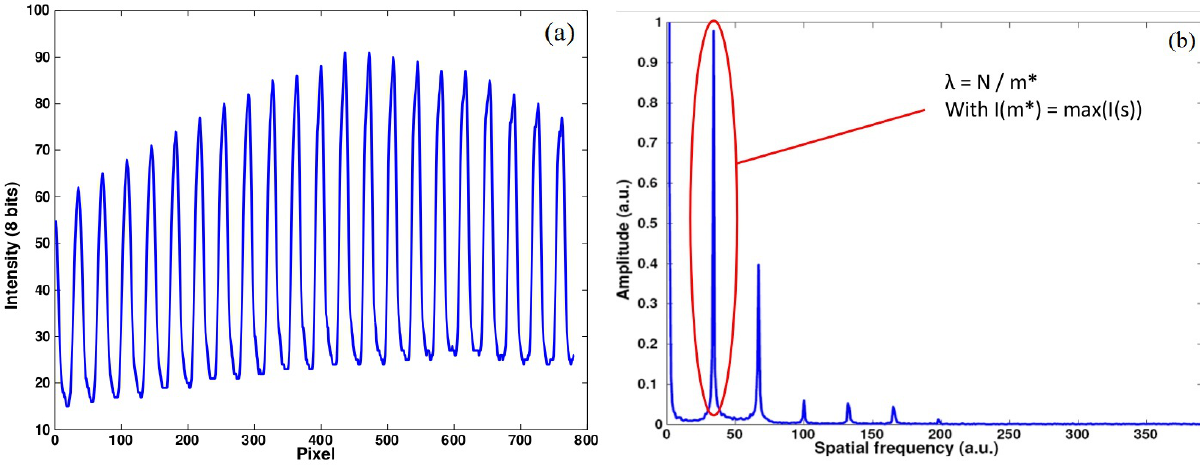
Figure 4. Example of intensity vector ( a ) of a real pattern and its Fourier transform ( b